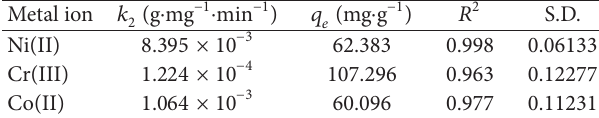
F 4: Pseudo-second-order kinetic plot for the biosorption of Ni(II), Cr (III), and Co (II) using Acalypha hispida leaf. T 2: Parameters of the pseudo-second-order kinetic model for the biosorption of Ni(II), Cr(III), and Co(II) using Acalypha hispida leaf.